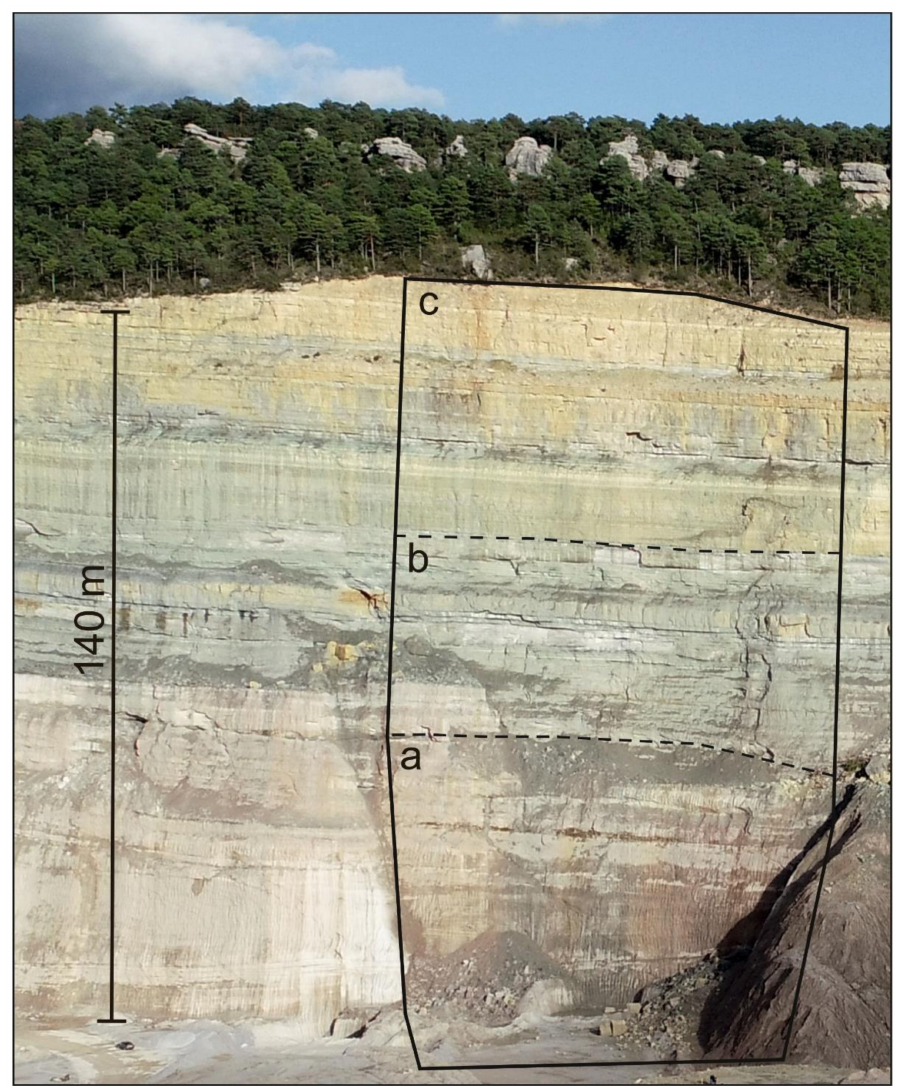
Figure 2. Oblique view of the studied sector in the highwall of the Mar í a Jos é mine. (a) kaolin sands; (b) marls; (c) limestones and dolostones. Photo by DGDRONE